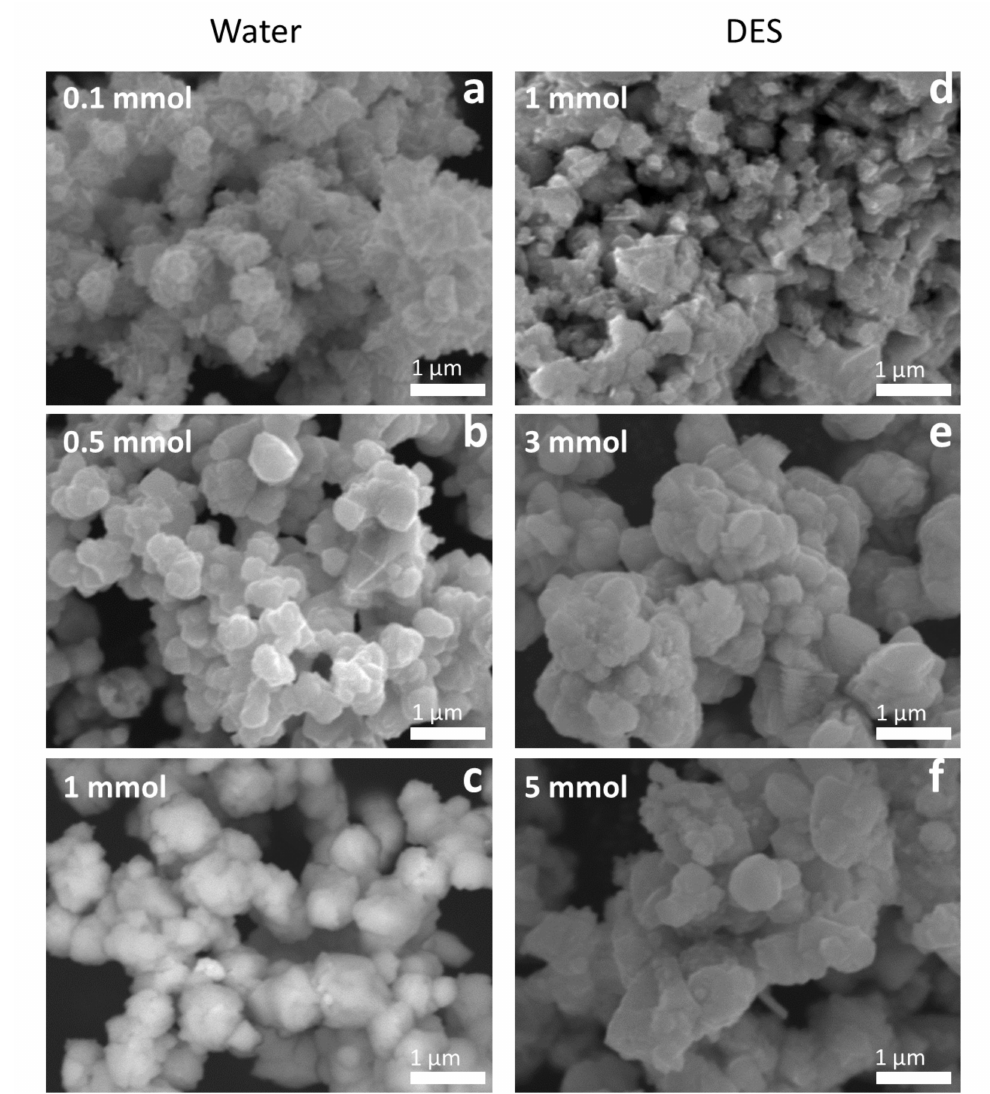
Figure 5. SEM images of the 2-step -synthesized AgInS 2 made with varying metal precursor concen- trations in water: ( a ) 0.1 mmol, ( b ) 0.5 mmol, and ( c ) 1 mmol; and in DES: ( d ) 1 mmol, ( e ) 3 mmol, and ( f ) 5